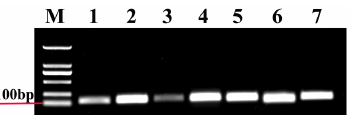
Figure 1. Agarose gel electrophoresis of these seven candidate reference genes. M, Molecular marker. Templates in the polymerase chain reactions (PCRs) were as follows: (1) 18S ; (2) Actin ; (3) ArgK ; (4) EF1A ; (5) RPL13 ; (6) RPS18 ; and (7) β-tubulin . Genes 2020 , 11 , 1178